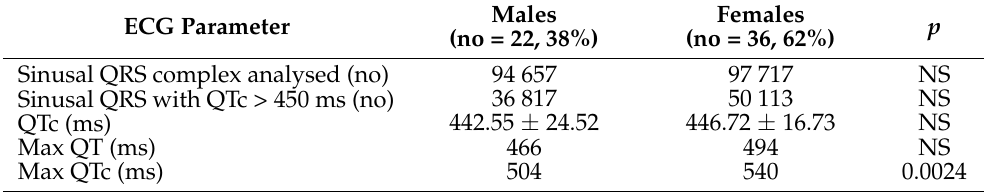
Table 2. Holter electrocardiographic parameters male vs. female patients.